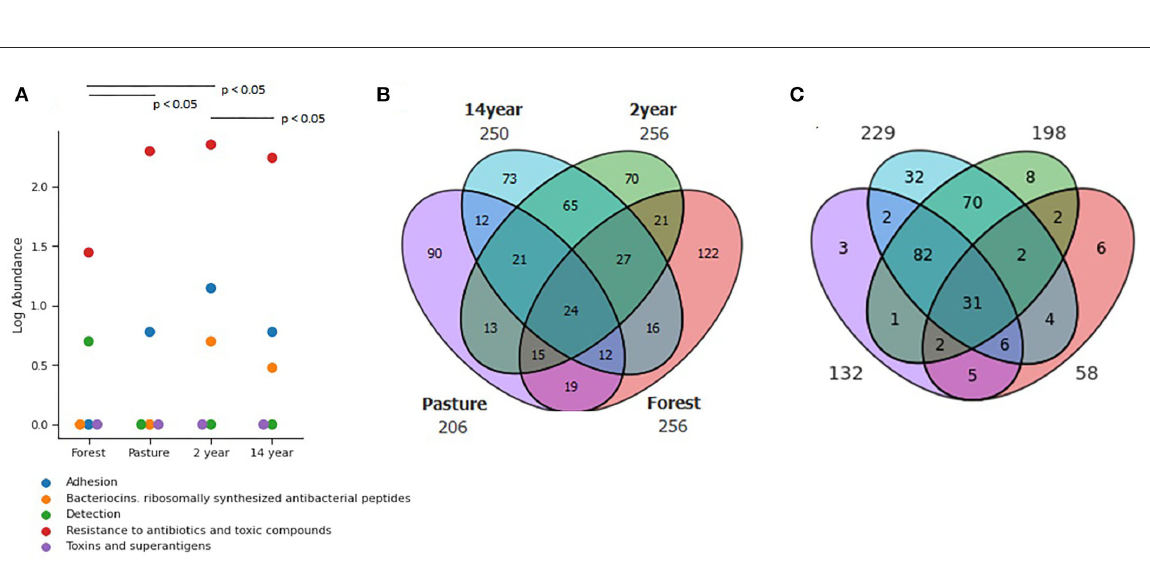
FIGURE4 Distribution of (A) Functional genes in different soils identified from the SEED Subsystems database, demonstrating clustered genes of virulence, disease, and defense at its second level. Venn diagram of identified genes from (B) Antimicrobial resistance identified from CARD database and (C) Biocide resistance in different soils identified from BacMet